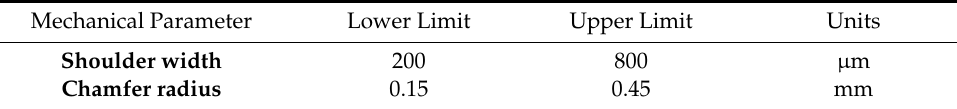
Figure 11. Illustration of the chamfer design. Table 2. Lower and upper limits of parameters.